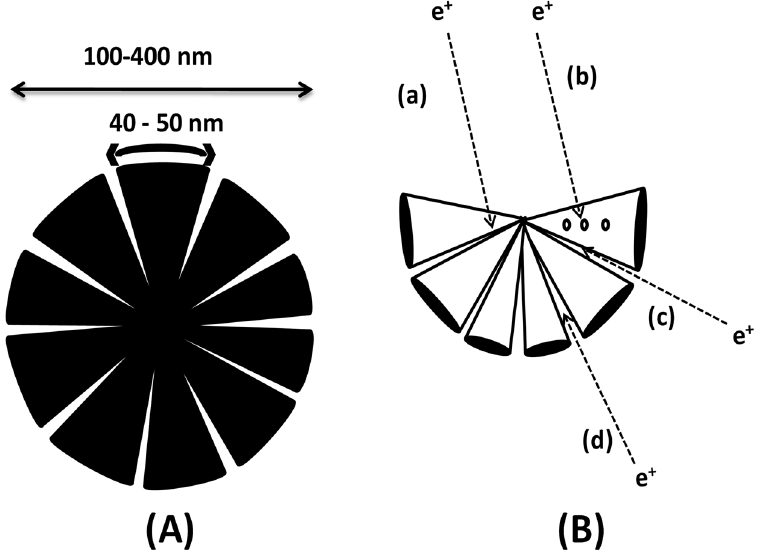
Figure 6. ( A ) Schematic diagram of the flower-like morphology ( B ) positron trapping at the open volume